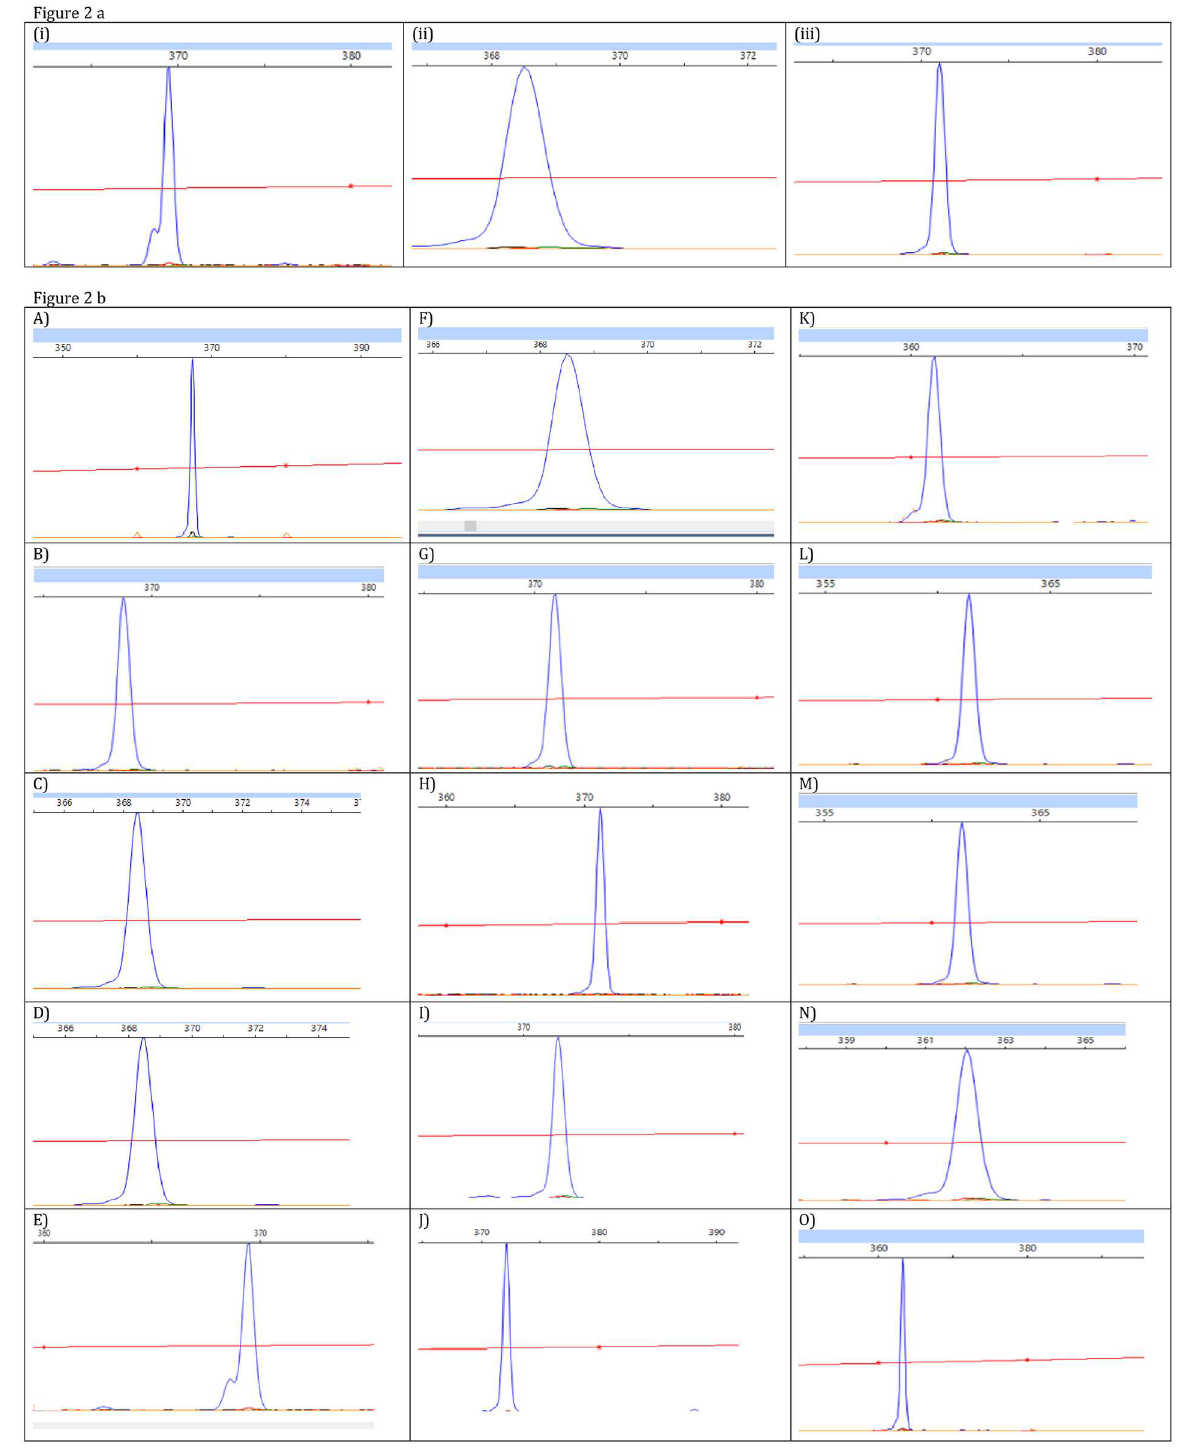
Fig 2. a. SCGE peaks of three representative ATCC strains. (i) M . asiaticum ATCC 25276 369 bp. (ii) M . avium ATCC 25291 368 bp. (iii) M . intracellulare ATCC 13950, 371 bp. b . Five SCGE fragment length types of M . avium , M . gordonae and M . intracellulare . All isolates were obtainedfrom clinical specimen. A) M . avium SCGE type I 367.44 bp B) M . avium SCGE type II 367.75 bp C) M . avium SCGE type III 368.44 bp D) M . avium SCGE type IV 368.49 bp E) M . avium SCGE type V 369.2 bp F) M . intracellulare SCGE type I 368.44 bp G) M . intracellulare SCGE type II 370.96 bp H) M . intracellulare SCGE type III 371.17 bp I) M . intracellulare SCGE type